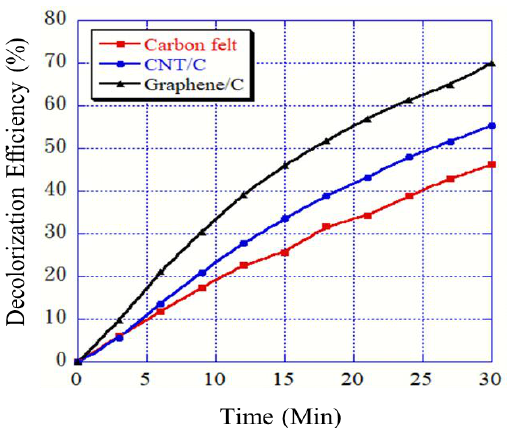
Figure 7. Plots of decolorization rates for different modifications of carbon felt in electro-Fenton system.